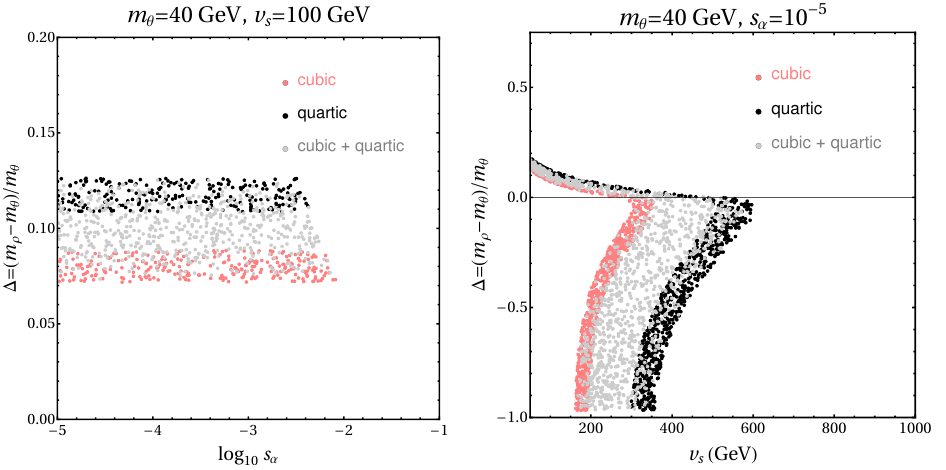
Figure 11. Left) Scan in ∆ and s α for the cubic and quartic models around the region of ∆ & 0 (FDM), similar to figure 4 (left). Points in gray correspond to the region of parameter space of the model which is the combination of both interactions and preserves DCP. Right) Scan in ∆ and v similar to figure 7 (left), enlarged with the combined